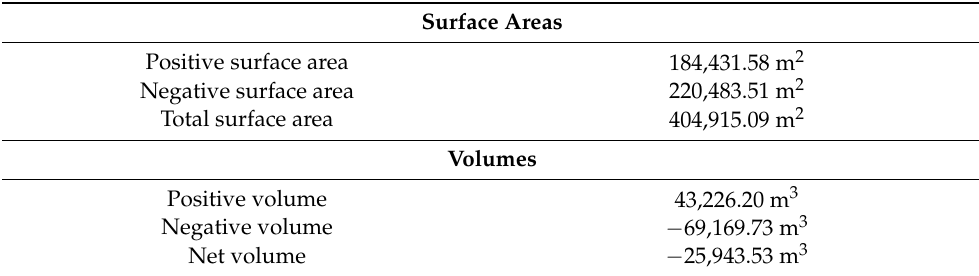
Table 1. Volumes and surface areas resulting from a comparison between the bathymetries from